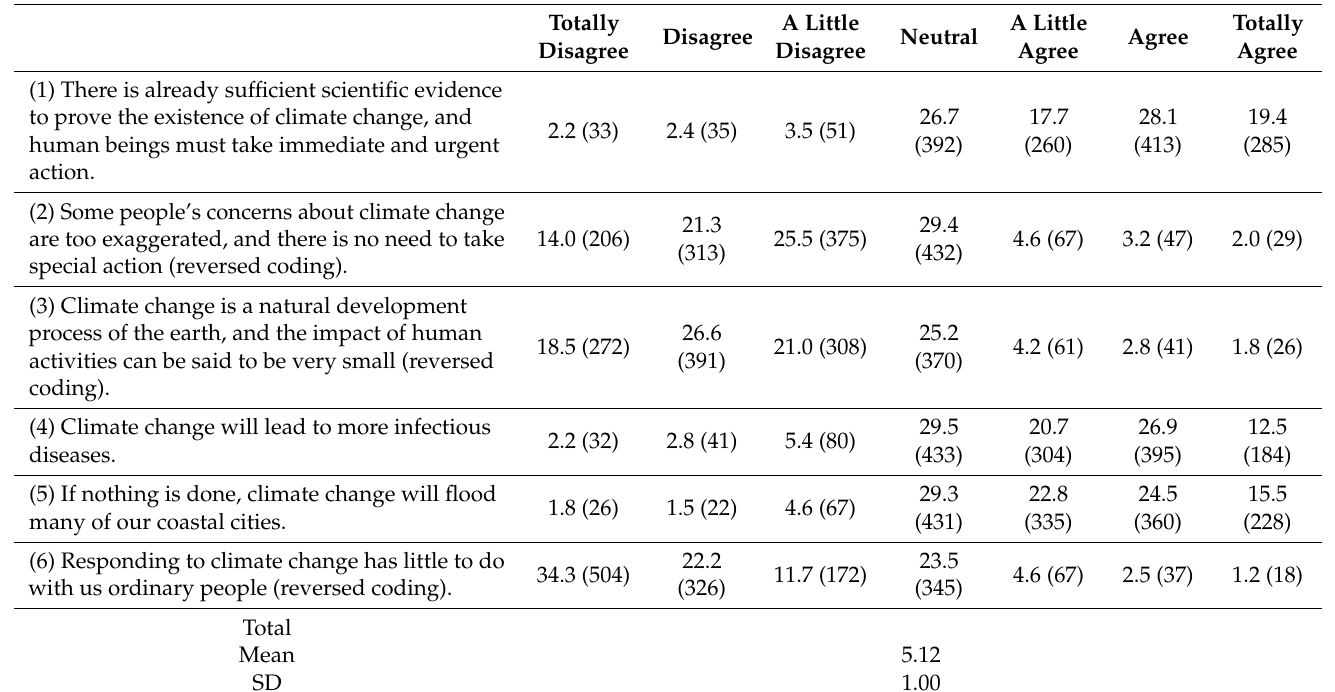
Table 2. Participants’ attitudes towards climate change ( n = 1469).